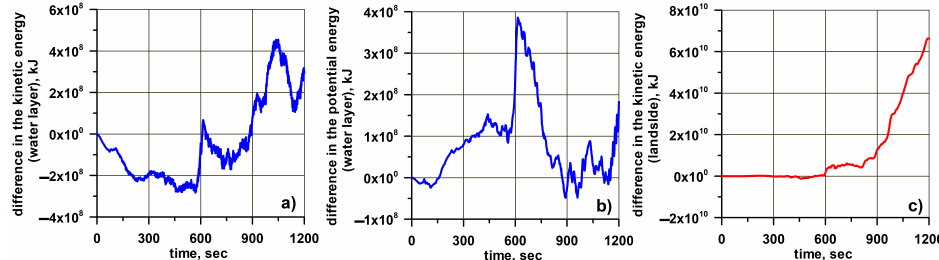
Figure 8. The difference in the energy between simulation for all landslides (BE-3) and summary en- ergy for individual simulation landslides. ( a ) Difference in kinetic energy (water layer); ( b ) difference in potential energy (water layer); ( c ) difference in kinetic energy (landslide).